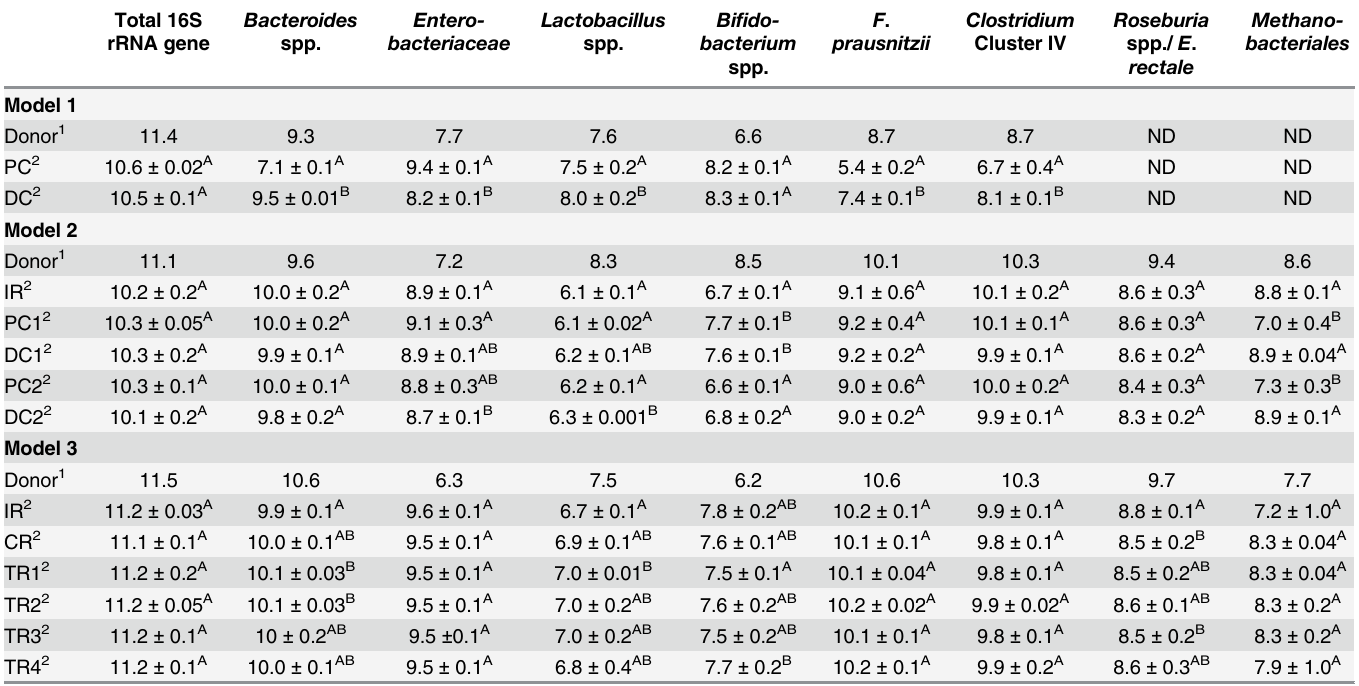
Table 1. qPCR enumeration of bacterial groups in fecal inocula and effluent samples of models ’ reactors at the end of the stabilization period. Total 16S rRNA